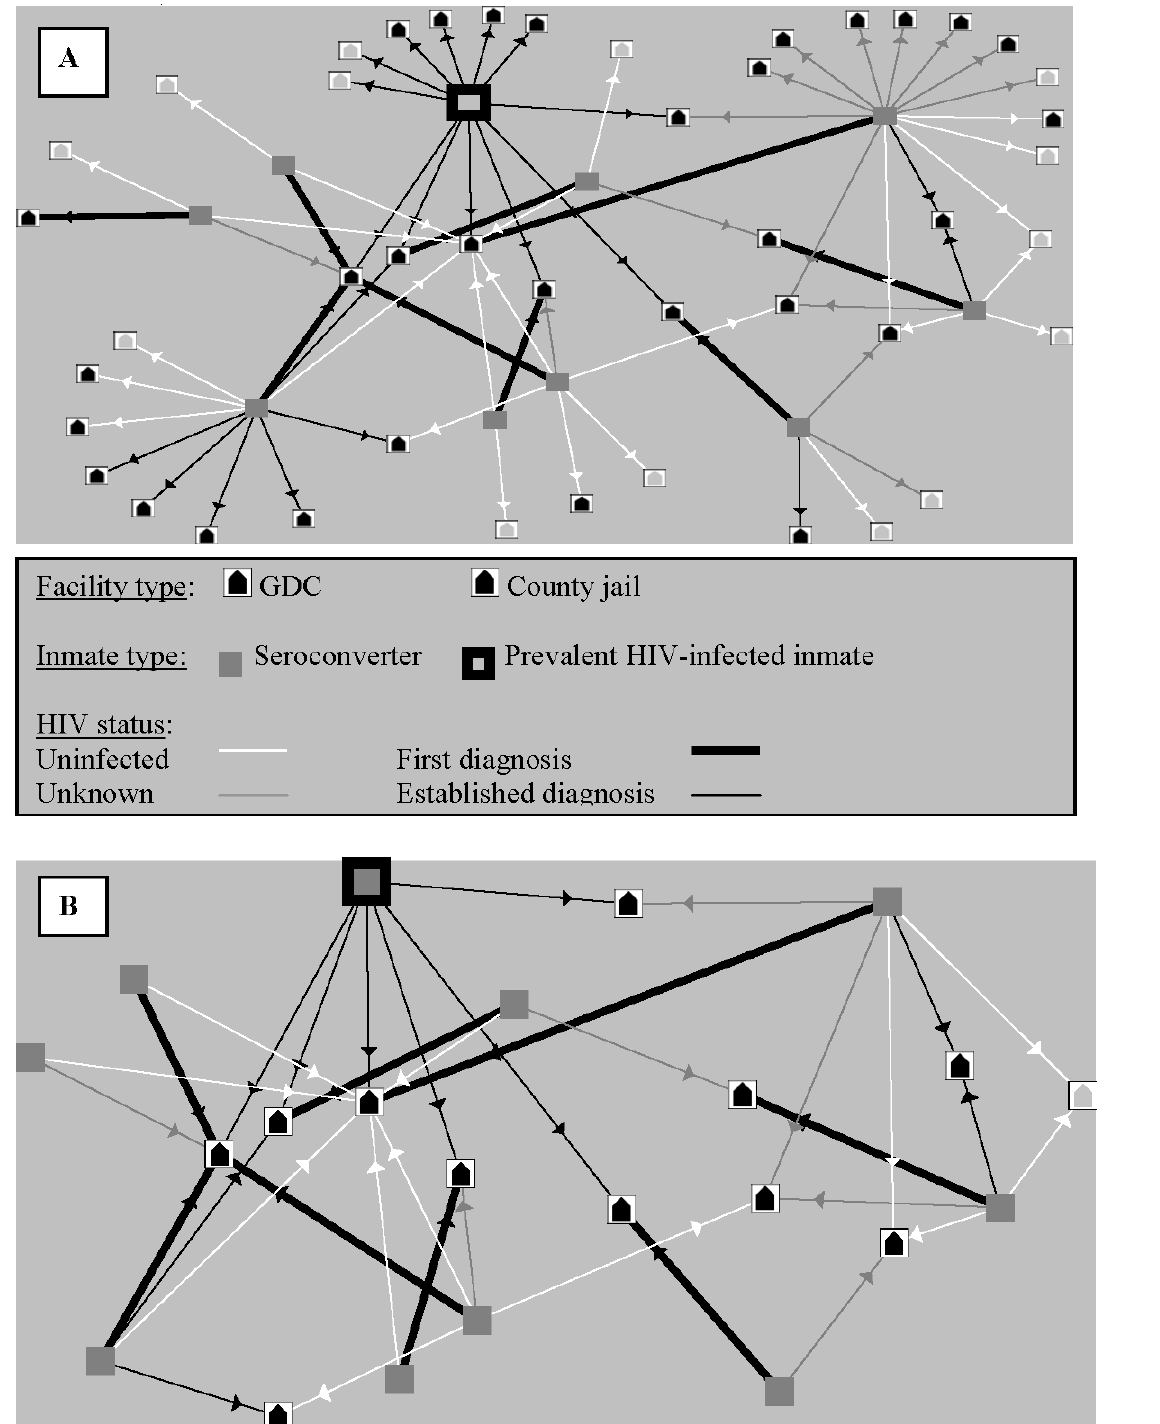
Figure 3. Transmission Network Diagrams Representing 10 Inmates ( & ) from the Largest Genetic Cluster Detected During an Investigation of HIV Transmission Among 88 Inmates, Georgia State Prison system, United States, 1988–2005.